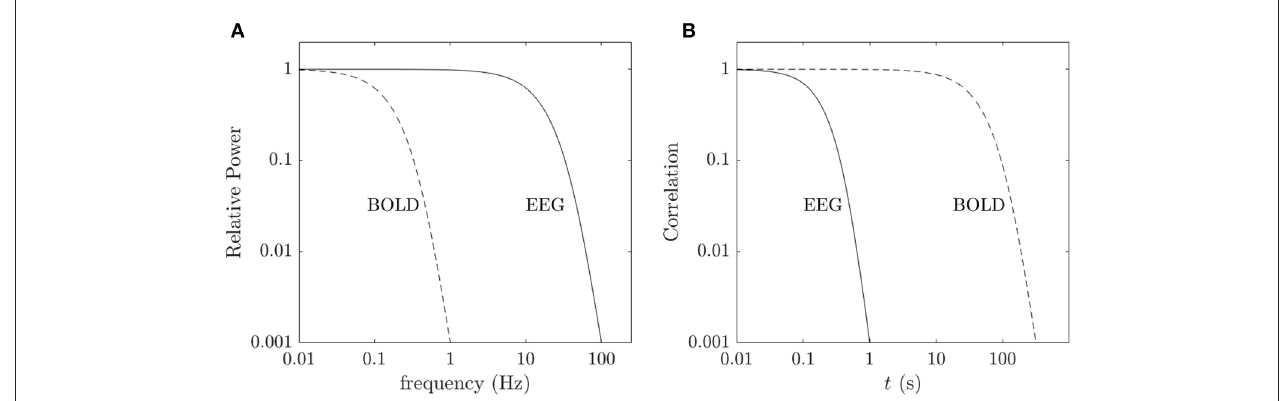
FIGURE 14 | Frequencies and timescales relevant to FC dynamics. (A) Schematic EEG (solid) and BOLD (dashed) spectra, with characteristic bandwidths of and 0.1 Hz, respectively. (B) Schematic correlation functions of EEG (red) and BOLD (blue) fluctuations, with characteristic correlation times of 0.1 s and 15 s, ∼